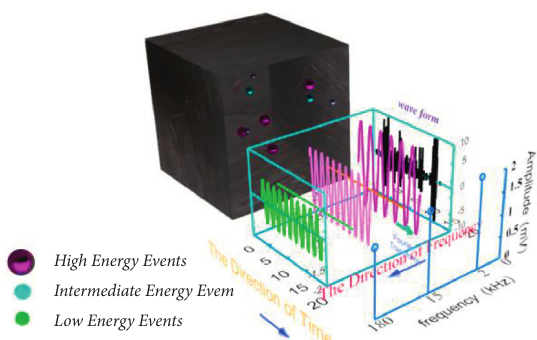
Figure 5: Deduction of the acoustic emission spectrum at the rupture